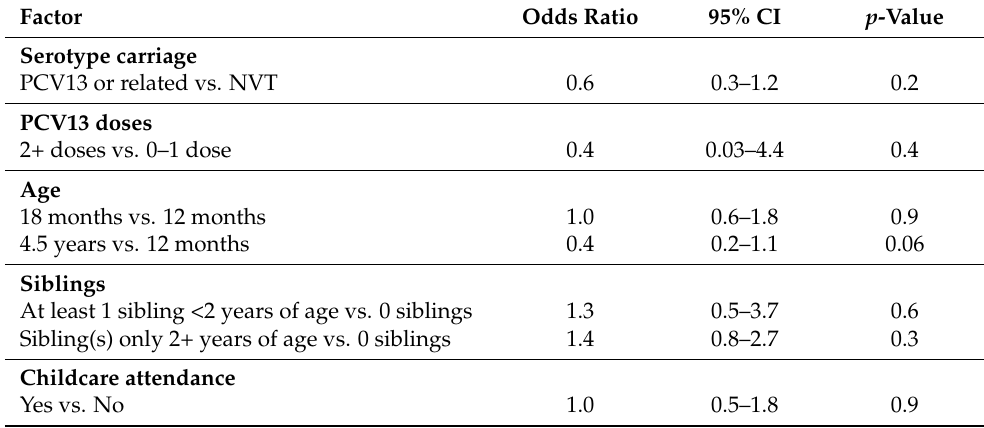
Table 3. Multivariable Logistic Regression Comparing Clinical Factors Associated With Being qPCR- pos and Culture-pos versus qPCR-pos